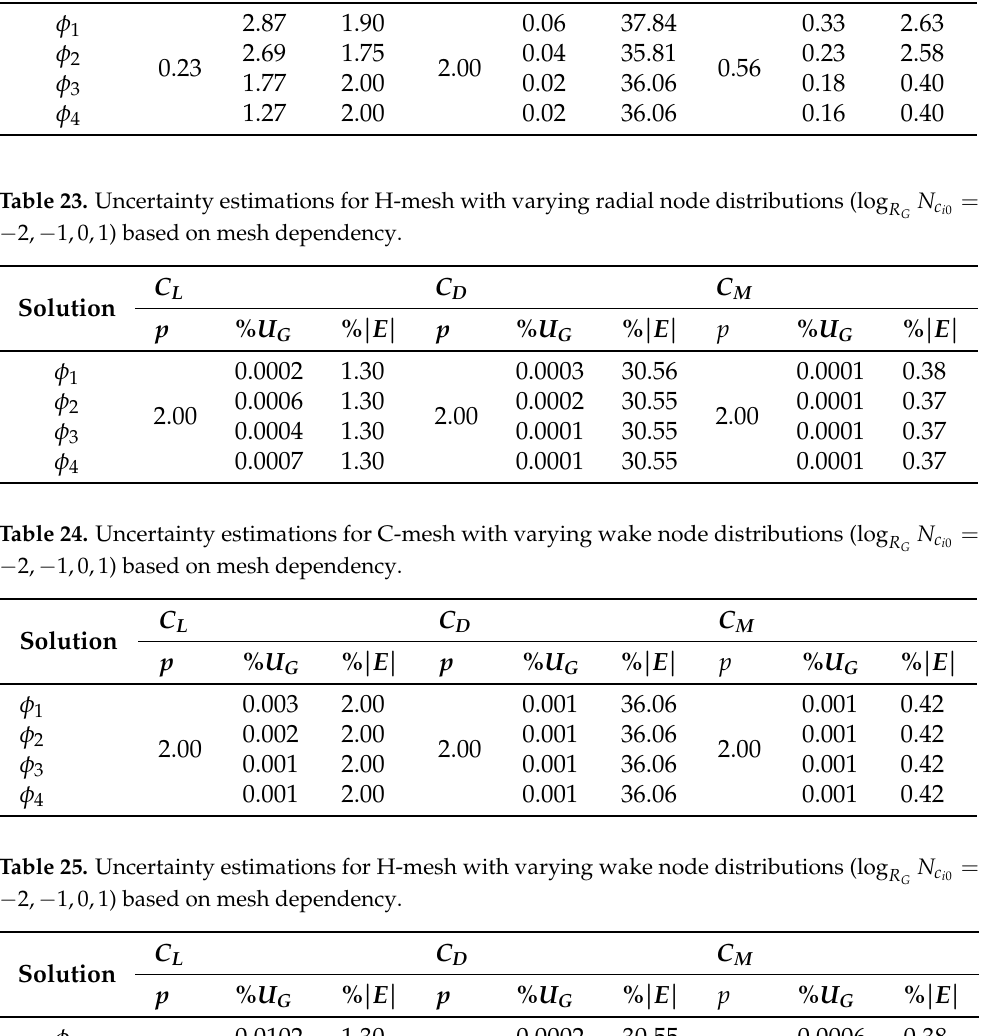
Table 22. Uncertainty estimations for C-mesh with varying radial node distributions (log 2, 1,0,1) based on mesh dependency. − −